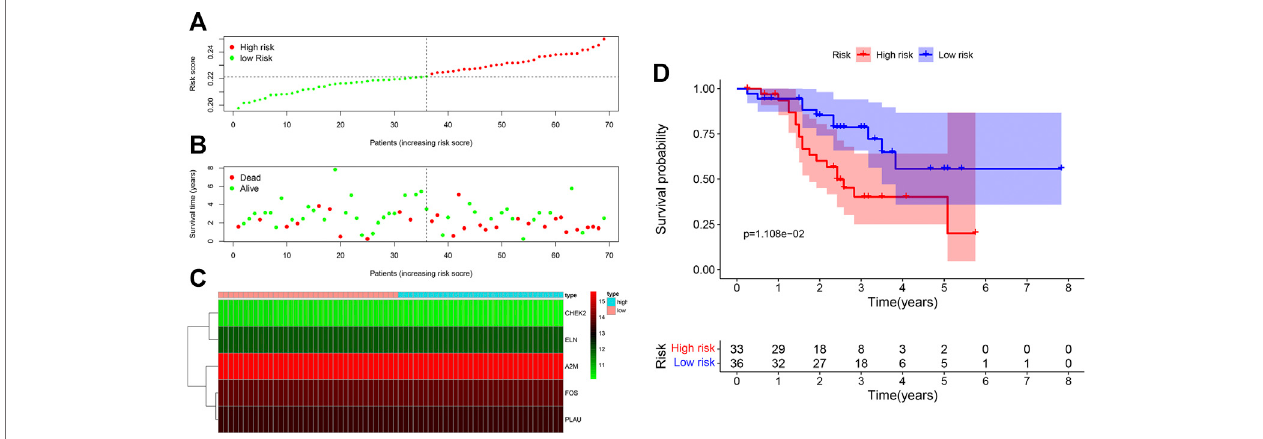
FIGURE 4 | Assessment of prognostic value of the ARG signature model in the GSE20685 validation cohort. (A) The distribution of risk scores in the GSE20685 cohort. (B) Patient distribution in the high- and low-risk groups according to overall survival status. (C) The heatmap showing expression pro fi les of the fi ve ARGs. (D) Kaplan-Meier curves for the overall survival of patients in the high- and low-risk groups.